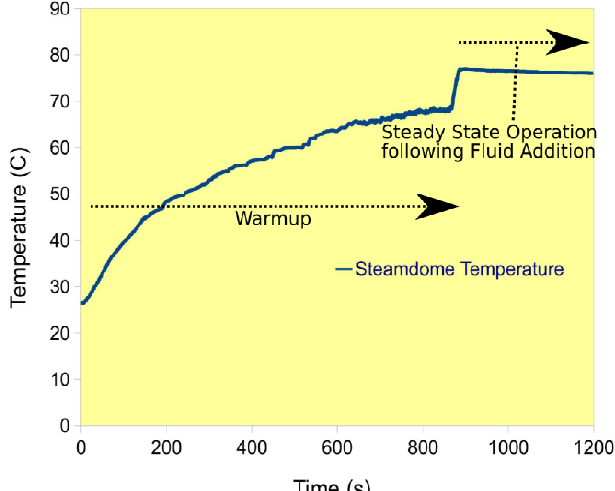
Figure 7. Typical temperature plot and test